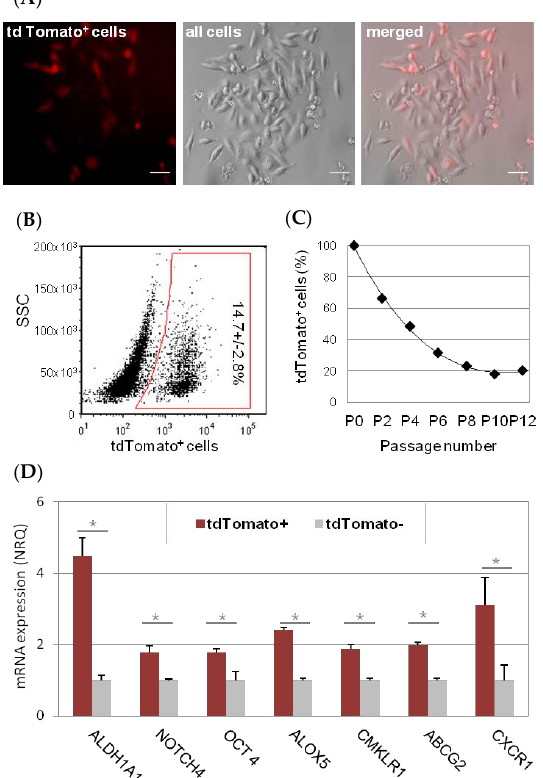
Figure 1. MDA-MB-231-ALDH1A1 / tdTomato cancer stem cell (CSC) model. After transfection with reporter vector ALDH1A1 / tdTomato, CSC-like cells express fluorescent reporter (tdTomato) under the CSC-specific promoter (ALDH1A1). Scale bar represents 20 µ m ( A ). This allows the CSC quantification and sorting by fluorescence-activated cell sorting (FACS) ( B ). Sorted tdTomato + cell population dropped and stabilized over passages ( C ). We confirmed by qPCR, that tdTomato + cells (CSC) express stem cell markers. Results are expressed as NRQ (relative normalized quantities) mean ± SEM ( n ≥ 3); * p < 0.05; ** p < 0.01, *** p < 0.001 ( D